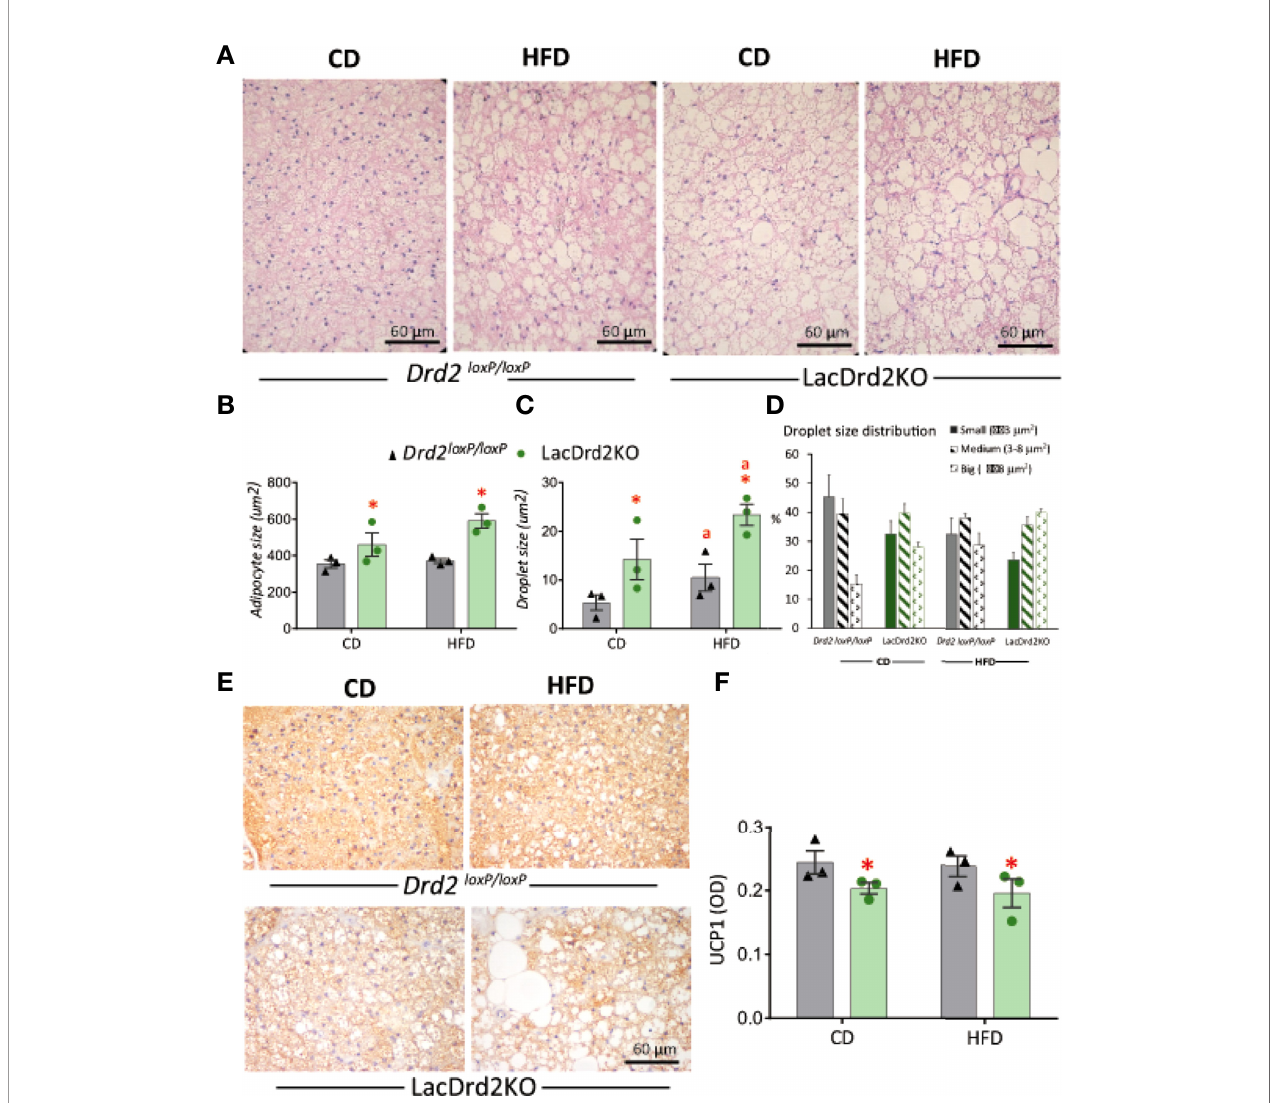
FIGURE 7 | Impact of hyperprolactinemia and high fat diet on brown adipose tissue architecture, and UCP1 staining (A) H&E staining of paraf fi n embedded samples of BAT from Drd2 loxP/loxP and lacDrd2KO female mice fed with control diet (CD) or HFD. Representative images captured at 40X magni fi cation using light microscopy. (B) Average adipocyte size ( m m 2 ) in BAT tissue from Drd2 loxP/loxP and lacDrd2KO female mice fed with control diet (CD) or HFD, n=3 for each group, * P = 0.0036 vs. Drd2 loxP/ loxP diet-matched mice; (C) Average droplet size ( m m 2 ) within brown adipocytes from Drd2 loxP/loxP and lacDrd2KO female mice fed with control diet (CD) or HFD, n = 3 for each group, * P = 0.0051 vs. Drd2 loxP/loxP diet-matched mice; “ a ” P = 0.037 vs CD, genotype-matched mice; (D) Percentage of droplets according to size (small ≤ 3 m m 2 , medium from 3.01 to 8 m m 2 , and big ≥ 8.01 m m 2 in the four experimental groups; (E) Representative images of UCP1 staining, (F) quanti fi cation of immunoreactive UCP1 from BAT samples from Drd2 loxP/loxP and lacDrd2KO female mice fed with control diet (CD) or HFD; n = 3 for each group, * P = 0.041 vs. Drd2 loxP/loxP diet-matched